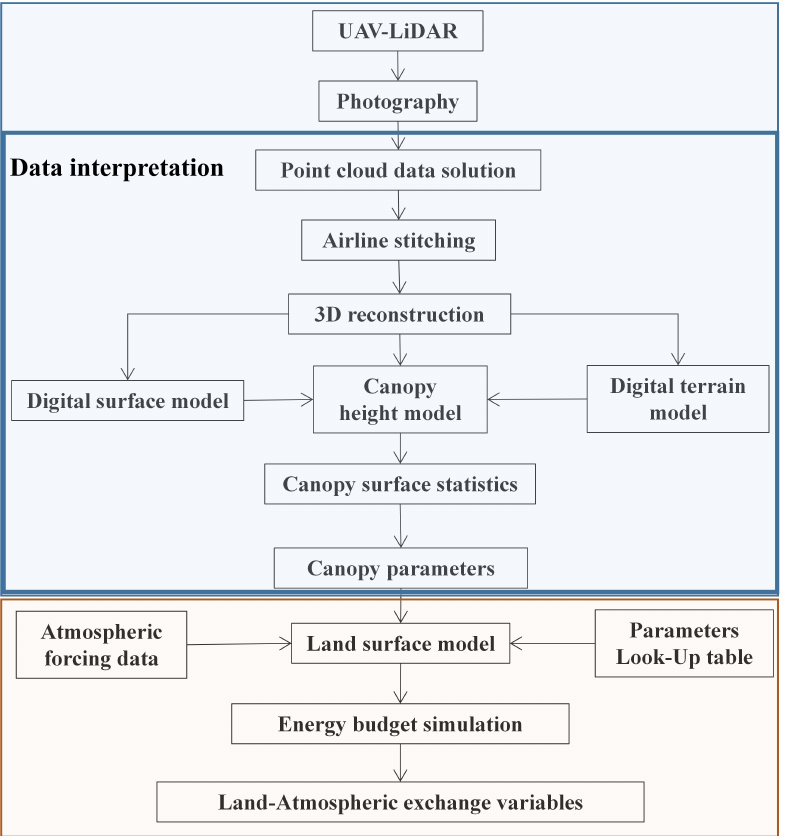
Figure 2. Flowchart for this